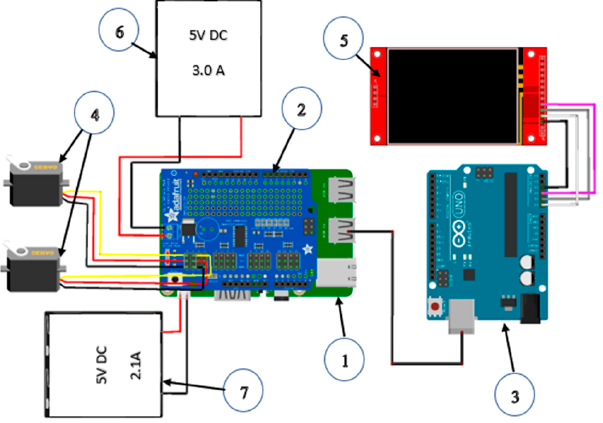
Figure 4. Ball-on-plate system dimensions.